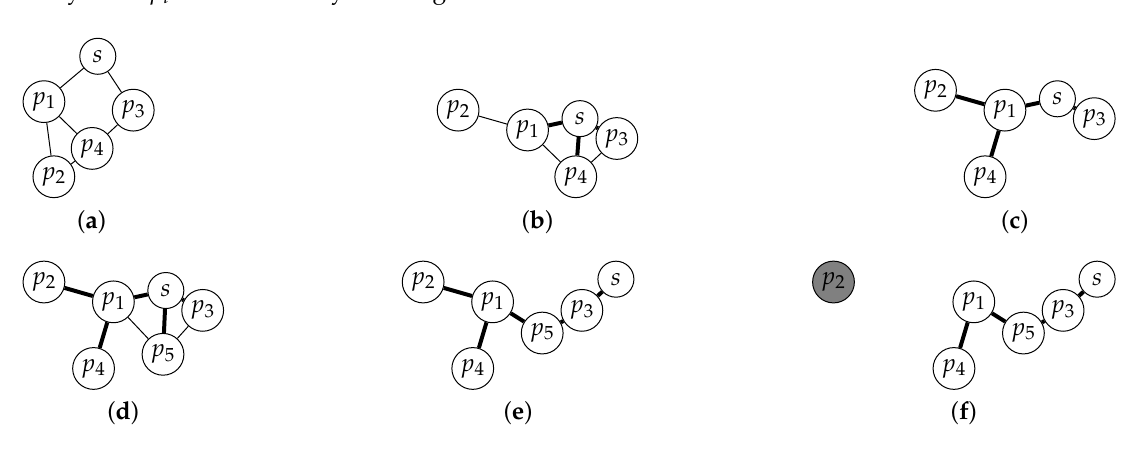
Figure 1. Example sequence illustrating how a spanning tree is built by our algorithms. Solid lines represent spanning tree arcs. ( a ) the sink node s starts executing the protocol; ( b ) the spanning tree is built from s ; ( c ) the spanning tree is complete. Observe that it has been reconfigured in the meanwhile; ( d ) a new node, p 5 , joins the network; ( e ) a new reconfiguration due to mobility; and ( f ) node p 2 disconnects from p 1 and becomes not